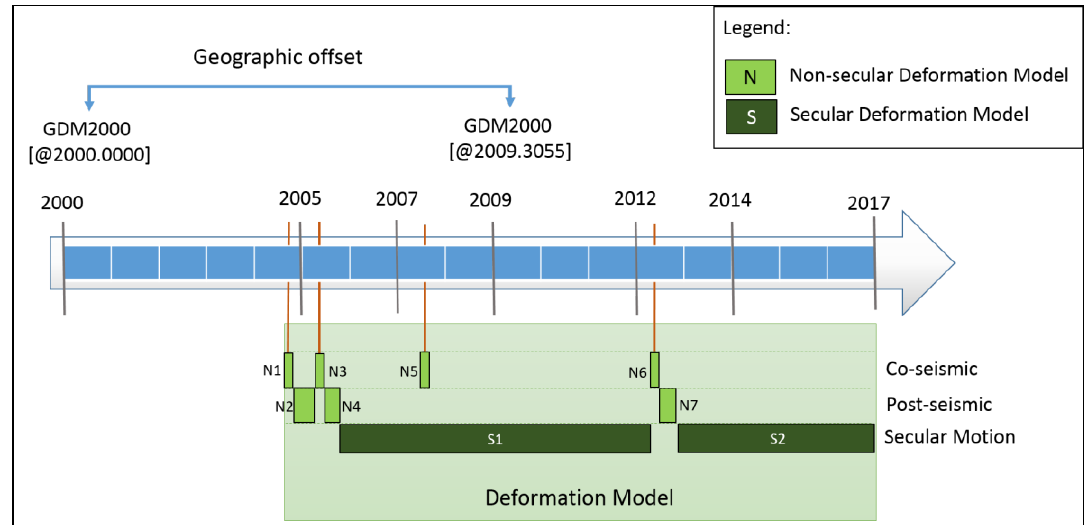
Figure 4. Timeline Proposal (2000 – 2017) for implementing a semi-dynamic datum for Malaysia. There will be 2 secular models representing the stable periods for Malaysia, which are S1 and S2. There are also 7 non-secular models each representing a co- seismic and post-seismic displacement from particular earthquakes. The N1, N3, N5 and N6 model represents the non-secular displacements due to the 2004 Sumatra-Andaman, 2005 Nias, 2007 Bengkulu and 2012 Northern Sumatra earthquakes, respectively. While the N2, N4 and N7 model represents the major post-seismic spike that occurs after the Sumatra-Andaman, Nias and Northern Sumatra earthquake, respectively. Both models will be used depending on the chosen target epoch, as well as the Geographic Offset transformation model. All models will be mapped with a 6‟ grid size, or ~11km, in order to reduce the chances of mismatch interpolation such as between the North-west and North-east region if the user‟s position is almost in between the two